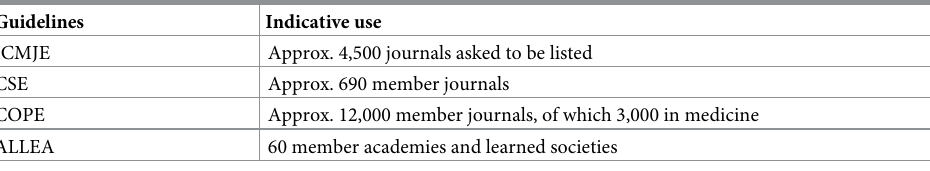
Table 1. Indicative prominence of authorship